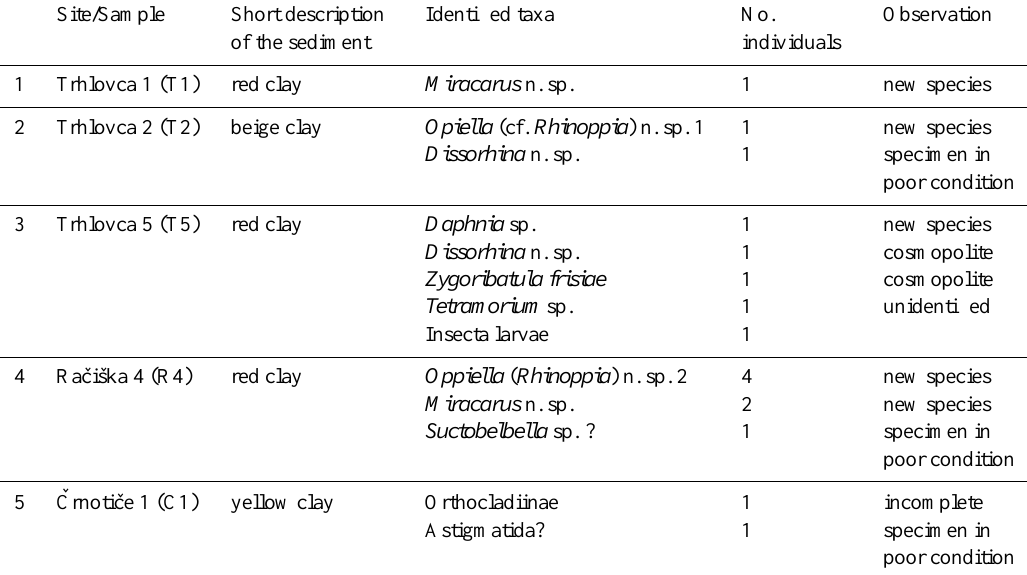
Table 1. A list of invertebrate fossils in the samples of cave sediments in Slovenia (only samples with identifiable animal remains are shown). Site/Sample Short description of the sediment 1 Trhlovca 1 (T1) red clay Miracarus n. sp. 1 new species 2 Trhlovca 2 (T2) beige clay Opiella (cf. Rhinoppia ) n. sp. 1 3 Trhlovca 5 (T5) red clay Daphnia sp. 4 Raˇciˇska 4 (R4) red clay Oppiella ( Rhinoppia ) n. sp. 2 5 yellow clay Orthocladiinae